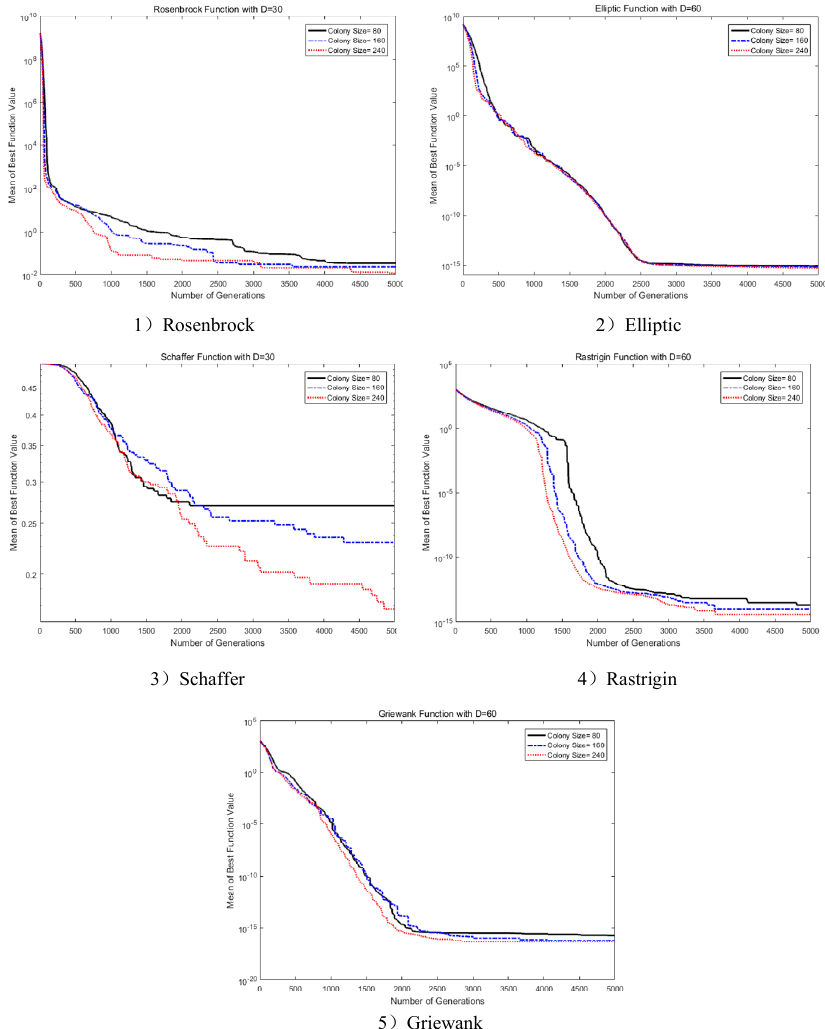
ff erent colony